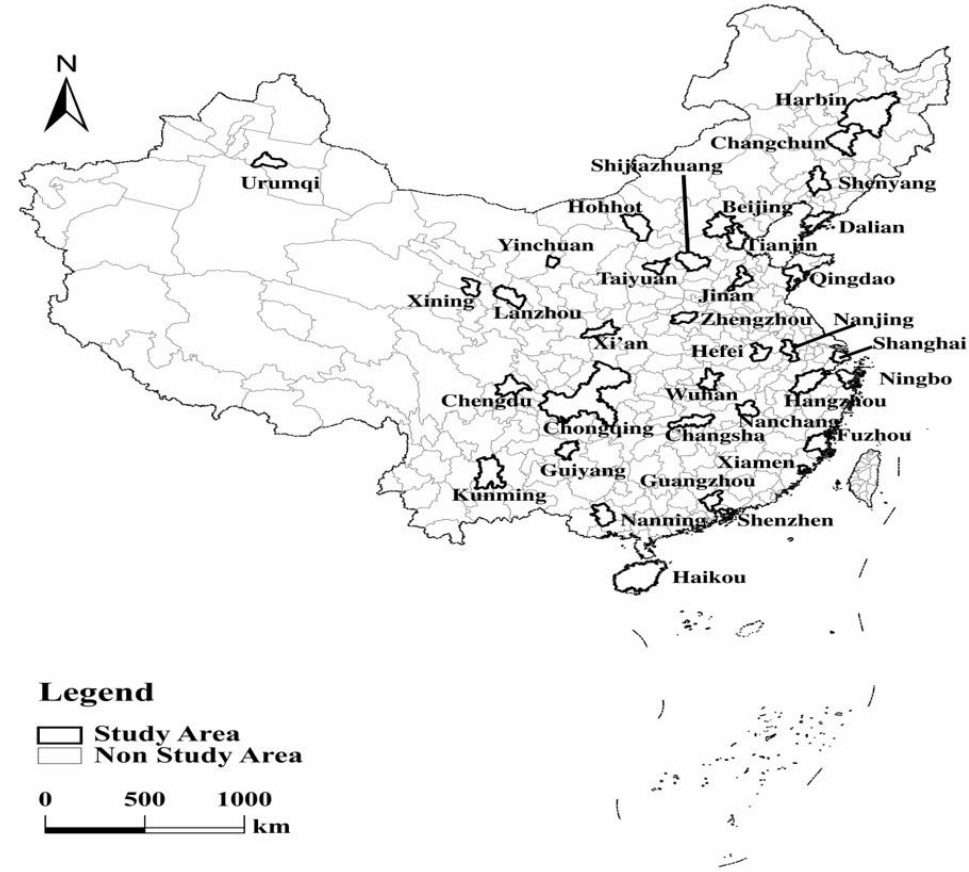
Figure 1. The distribution of 35 major cities in China.